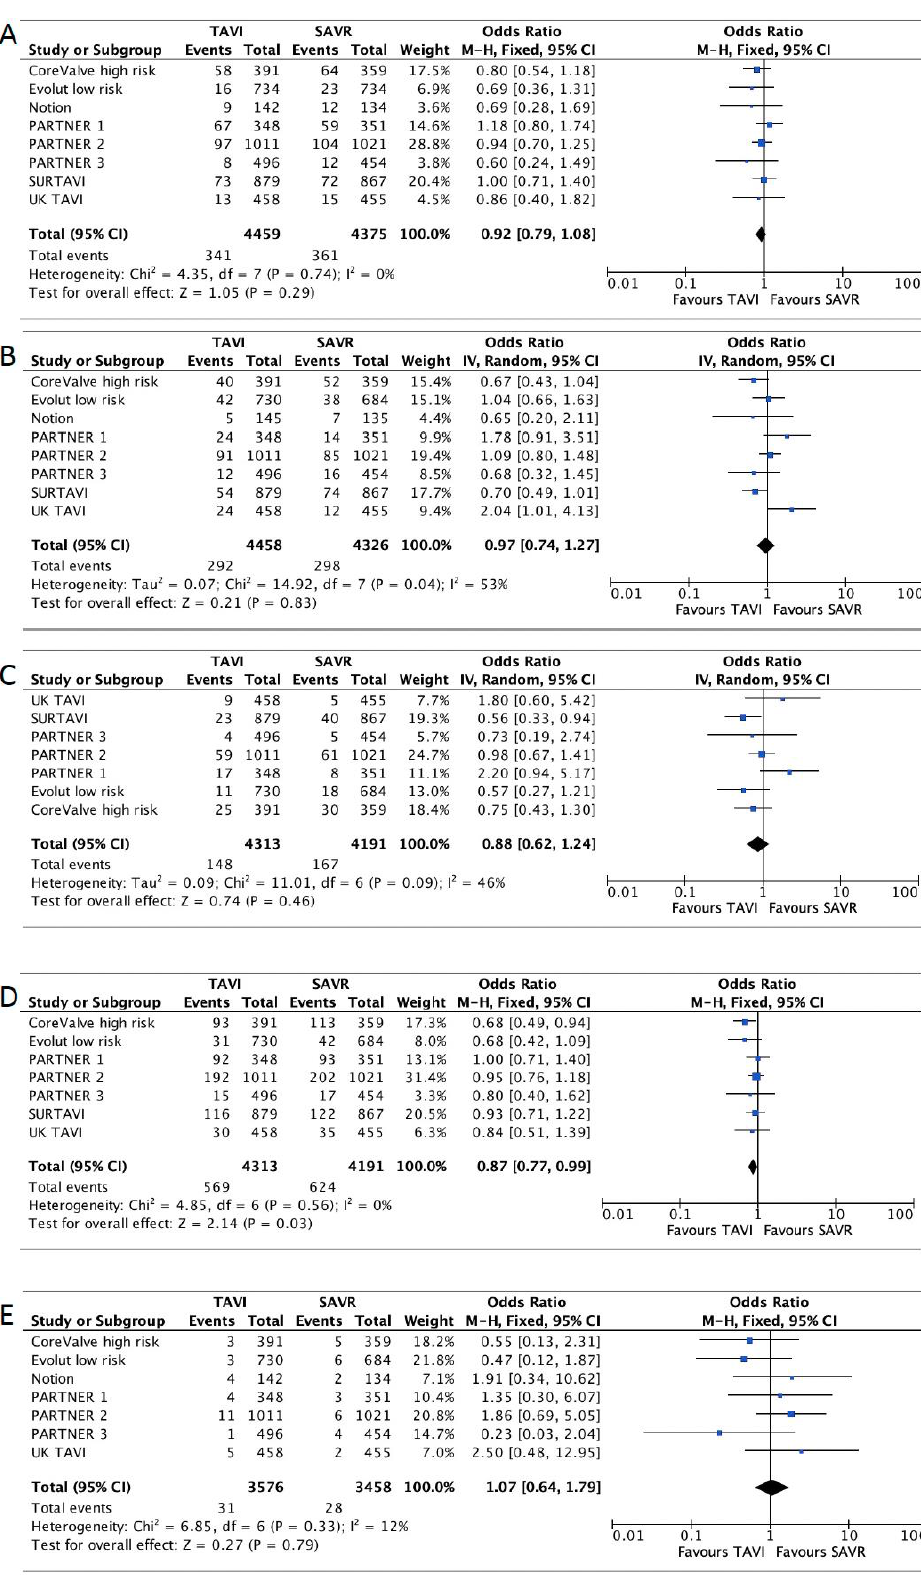
Figure 3. Forest plots for cardiovascular mortality ( A ), stroke ( B ), disabling stroke ( C ), all-cause mortality or disabling stroke ( D ), endocarditis ( E ).